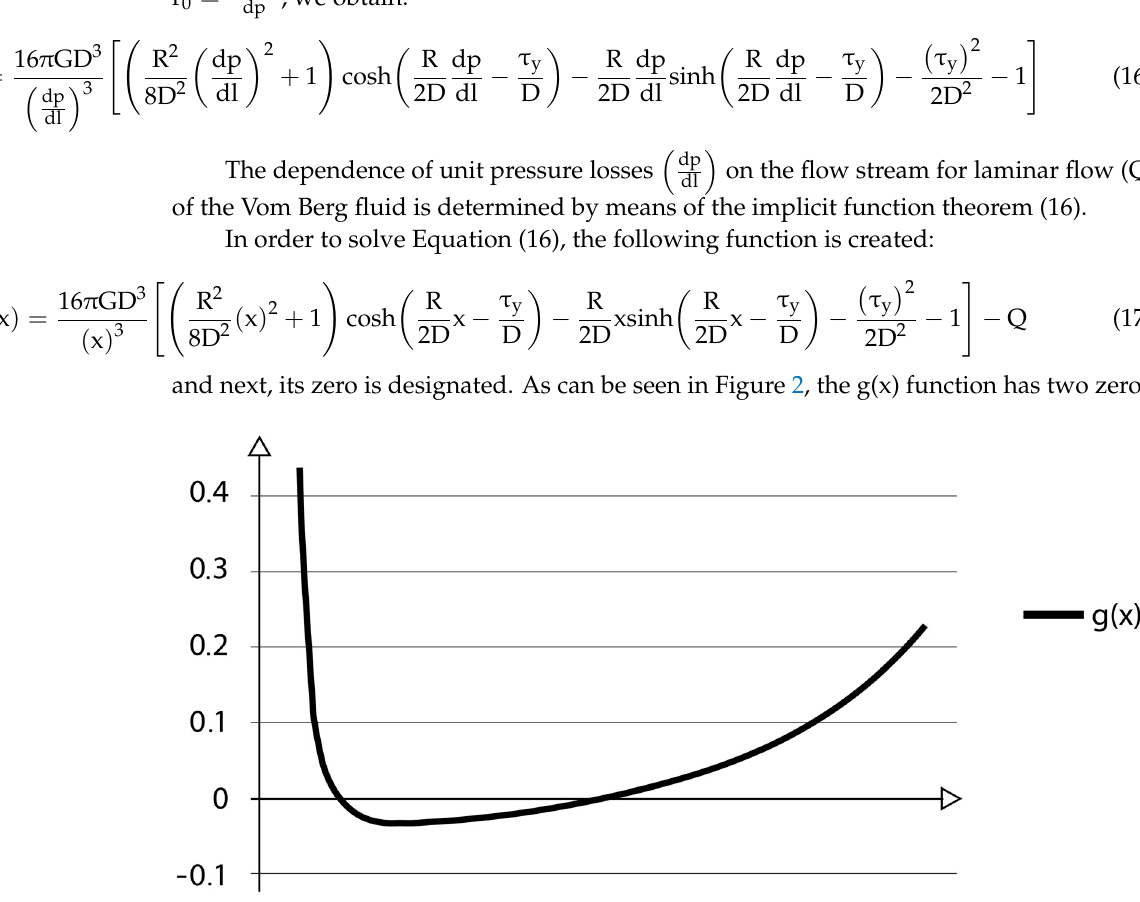
Figure 2. g(x) function graph.